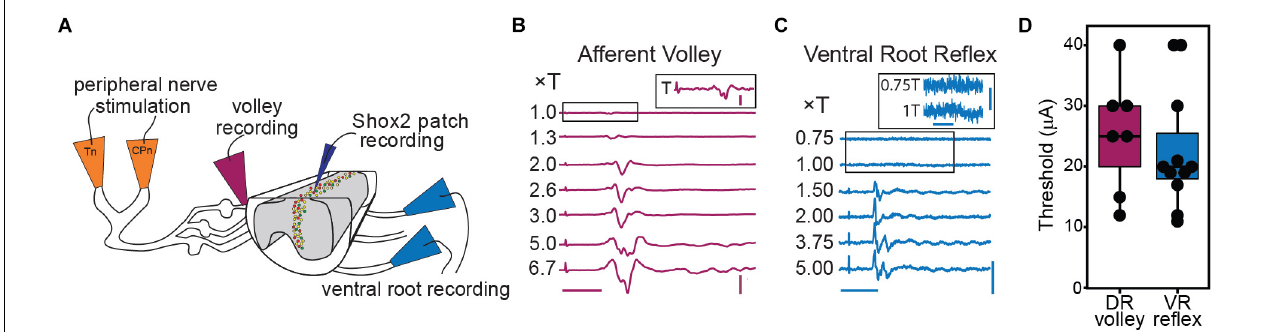
FIGURE 3 | Graded afferent stimulation in the lumbar-hemisected isolated spinal cord preparation. (A) Cartoon of hemisected isolated cord preparation from Shox2::cre;Rosa26-lsl-tdTomato;Chx10GFP mice (Shox2 RG Shox2 + Chx10 − ) neurons are red and Shox2 PF (Shox2 + Chx10 + ) neurons are yellow. (B) Examples of afferent volley recorded from L4 DR following Tn stimulation. The inset shows the boxed region of the 1.0 × T stimulation on a larger scale for clarity. The deflection on the far left of each trace is the stimulus artifact. Horizontal scale bar is 20 ms. Vertical scale bar is 0.8 mV for main figure and 0.08 mV for inset. (C) L4 ventral root reflexes recorded during stimulation of Tn at different stimulation intensities. Threshold was defined as the minimum current necessary to detect a response in the L4 ventral root following CPn or Tn stimulation. The boxed regions of 0.75 and 1.0 × T are shown on a different scale in the inset for clarity. The deflection seen at 1T was small yet consistent. Horizontal scale bars are 20 ms. Vertical scale bar is 0.1 mV for main figure and 0.01 mV for inset. (D) Stimulation intensities at threshold for afferent volley and ventral root reflexes following Tn stimulation are plotted. In most preparations, either afferent volley or ventral root reflexes were recorded, but not